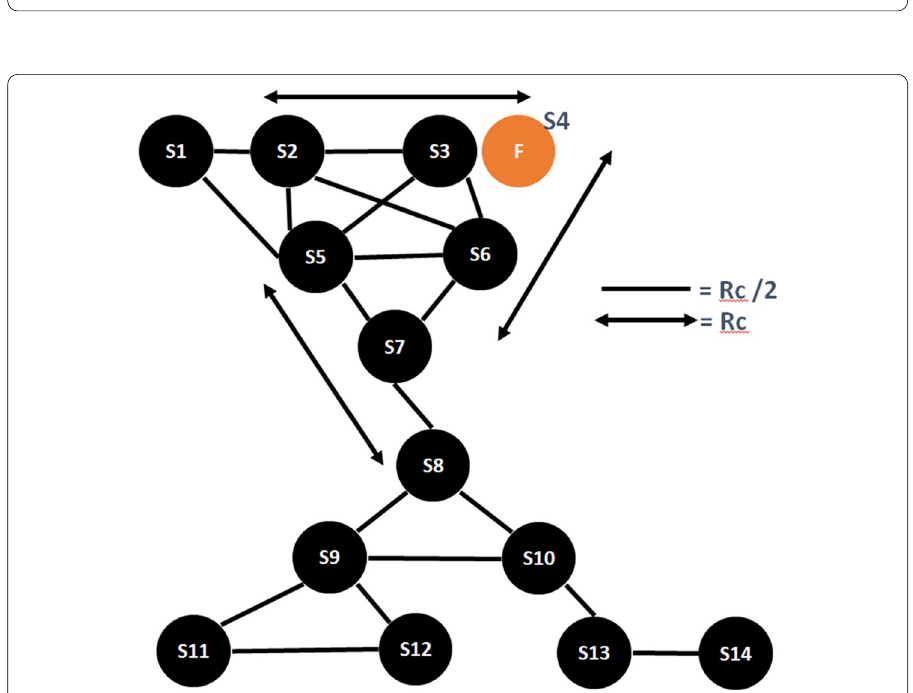
Fig. 4 Recovery from end node